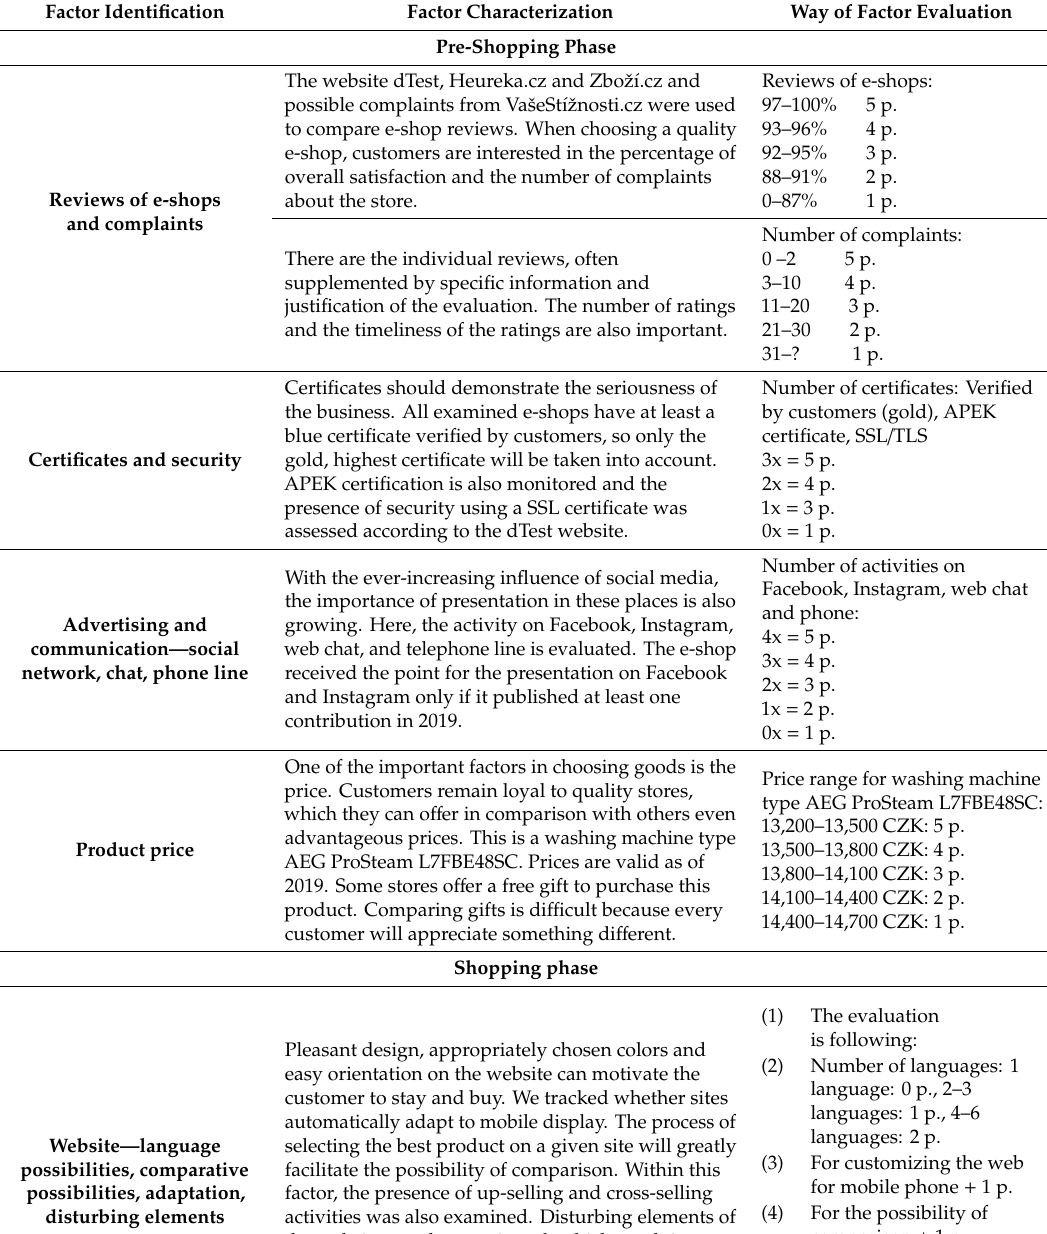
Table 1. Factors influencing online shopping behavior in the industry of online sales of white electronics. Source: own